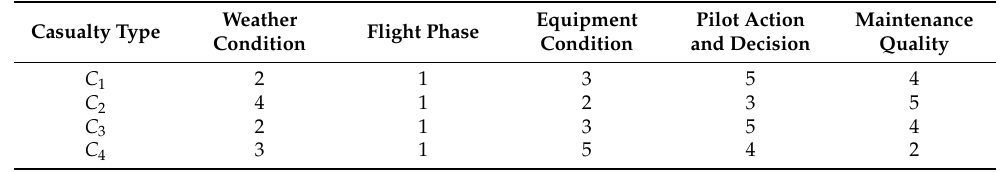
Table 6. The most important factors.